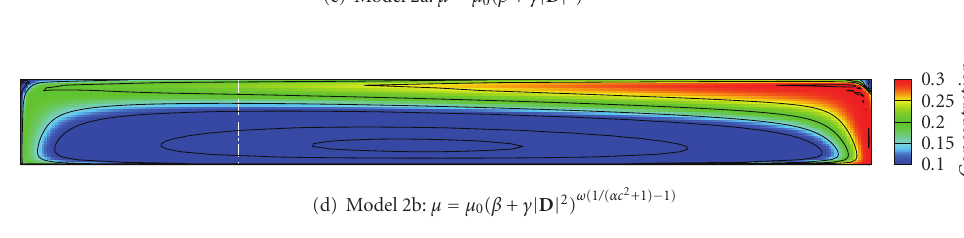
Figure 7: Concentration